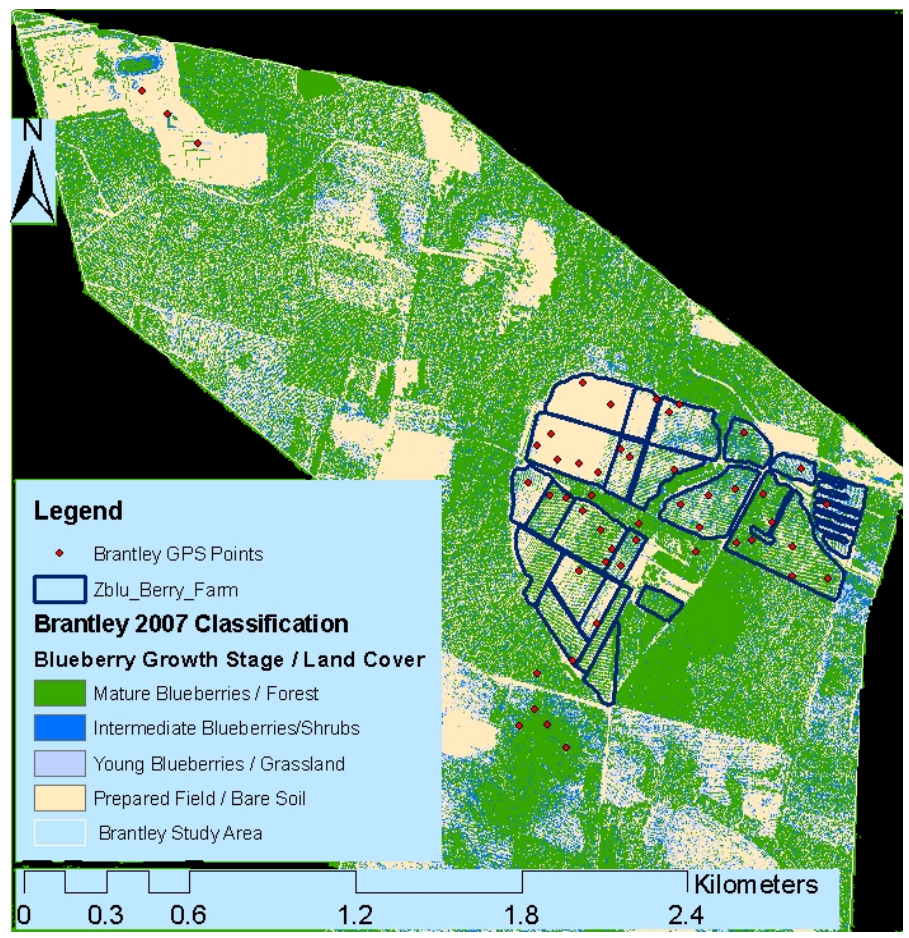
Figure 5. SOM classified image of Brantley County study area along with ground truth points (50 points) and GPS-recorded blueberry orchards at different